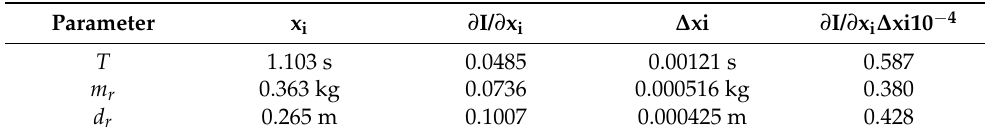
Table 2. Average values, partial derivation, standard deviation, and the influence of every parameter in error for the case of horizontal